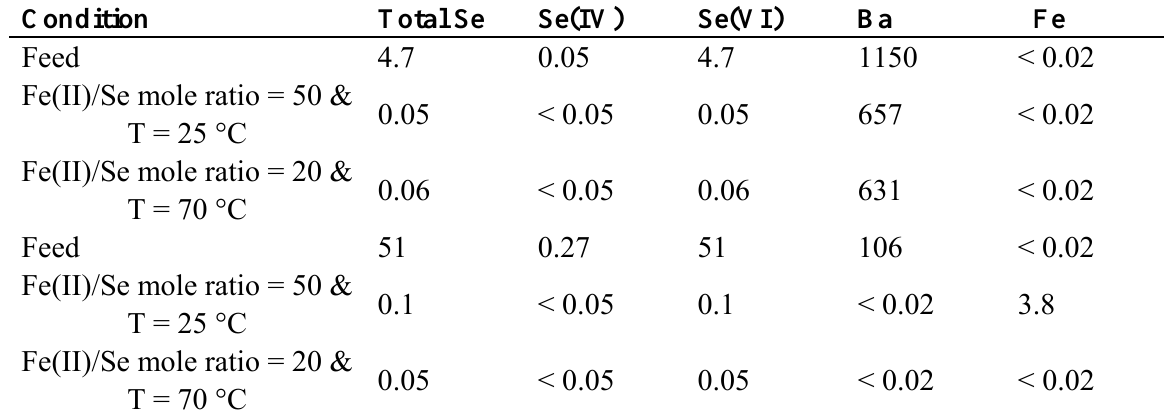
Table 3. Analysis of filtrates from the third stage (mg/L).